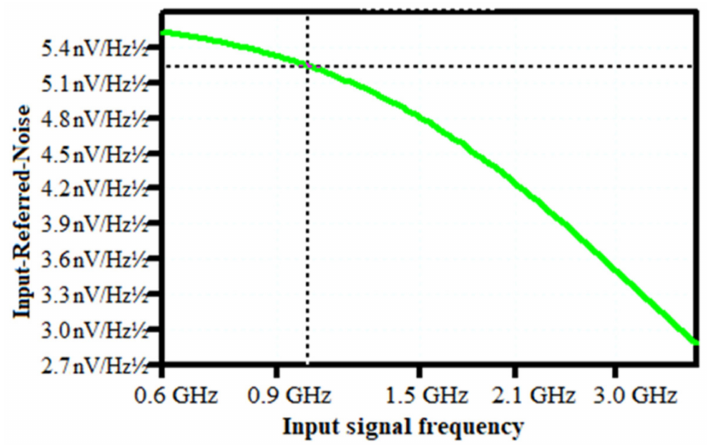
Figure 9. CSA Input-Referred Noise.